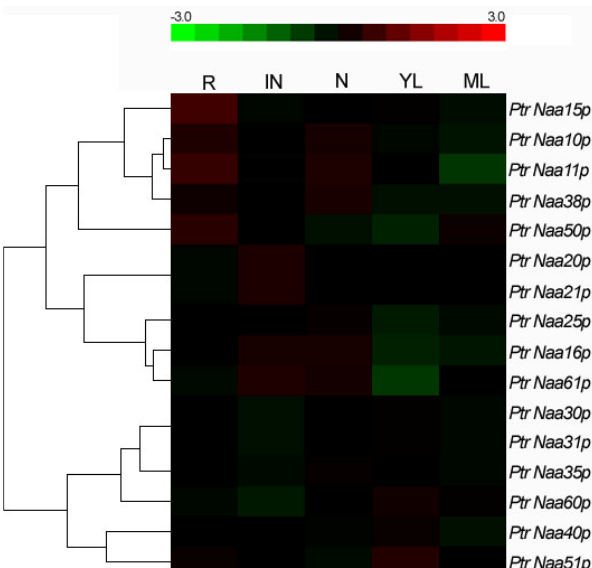
Figure 4. Relative transcript abundance profiles of Populus Nat CS and AS genes across different tissues. A heat map displaying the transcript abundance is produced here using the genome-wide microarray data generated by Wilkins and coworkers [26]. The transcript abundance levels for the Populus Nat CS and AS genes were clustered using hierarchical clustering based on the Pearson correlation. The color scale at the bottom of each dendrogram represents log2 expression values, green color represents low level, red color represents high level of transcript abundances and black color represents no transcript expression. The symbols represent as follows: R, root; IN, internodes; N, nodes; YL, young leaf; ML, mature